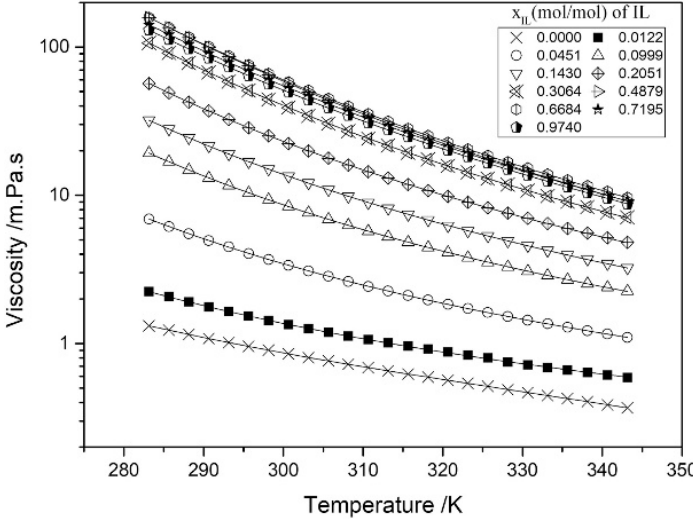
+ H 2 O, 283.15–343.15 K, 0.1 MPa [14]. Copyright 2018